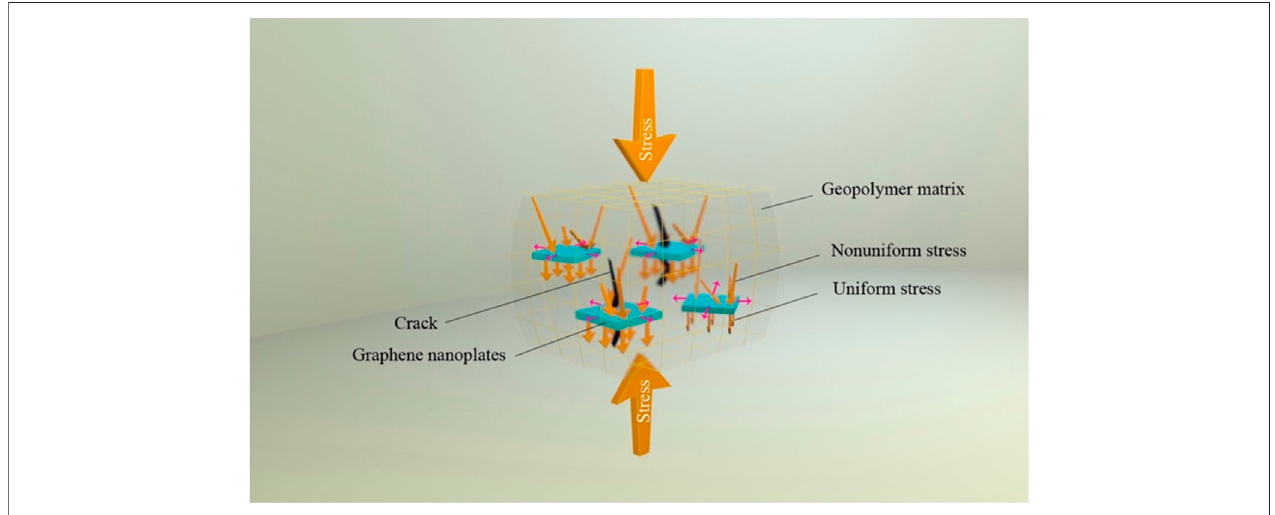
FIGURE 4 | Schematic diagram on the compressive behavior of graphene/geopolymer nanocomposite (Ranjbar et al., 2015)